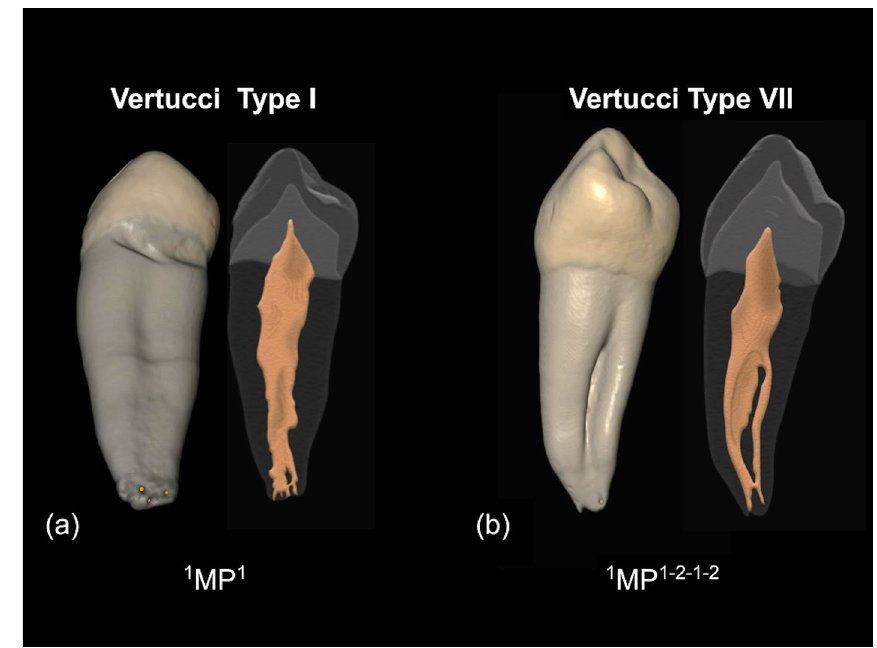
Figure 5. Micro-CT images showing the external and internal anatomical features analyzed in mandibular first premolars. ( a ) Non-Tomes’ root (ASUDAS grade 0), containing a single root canal (above, Vertucci’s classification Type I; below, Ahmed’s criteria 1 MP 1 ) and the presence of apical delta and multiple apical foramina in the apical third of the root. ( b ) Tomes’ root (ASUDAS grade 3), containing multiple root canals (above, Vertucci’s classification Type VII; below, Ahmed’s criteria 1 MP 1–2–1–2 ) and the presence of C-shaped canal in the middle third of the root. MP mandibular first premolar (Images obtained using the CTAn v.1.12 software,